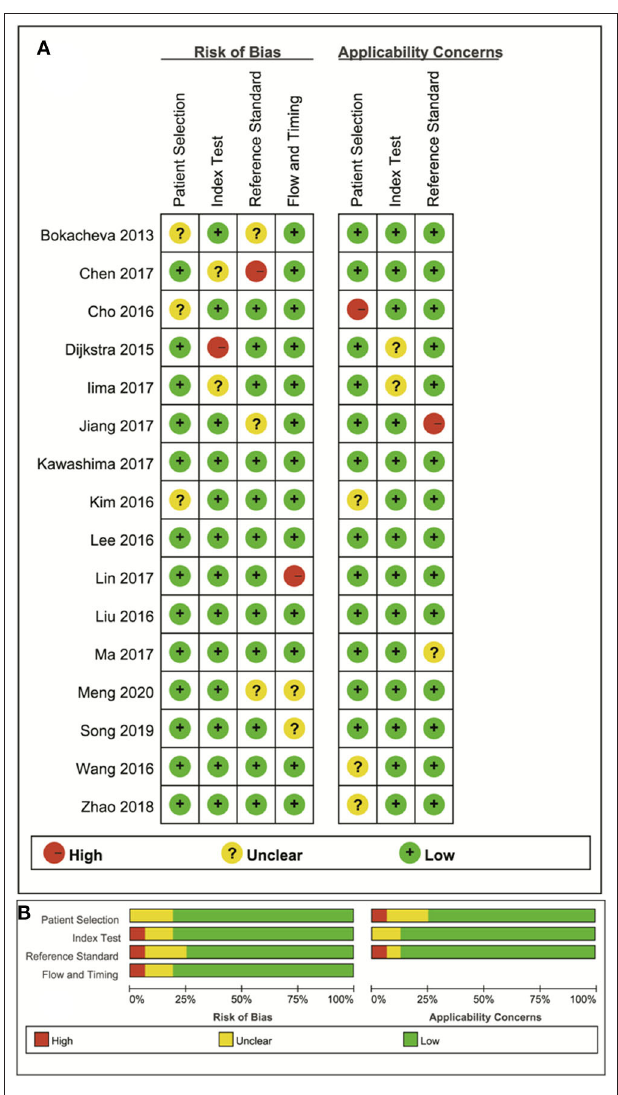
FIGURE 2 | The distribution of risk of bias and applicability concerns for each included study using Quality Assessment of Diagnostic Accuracy Studies-2 (QUADAS-2) (A) and a summary of the methodological quality (B)